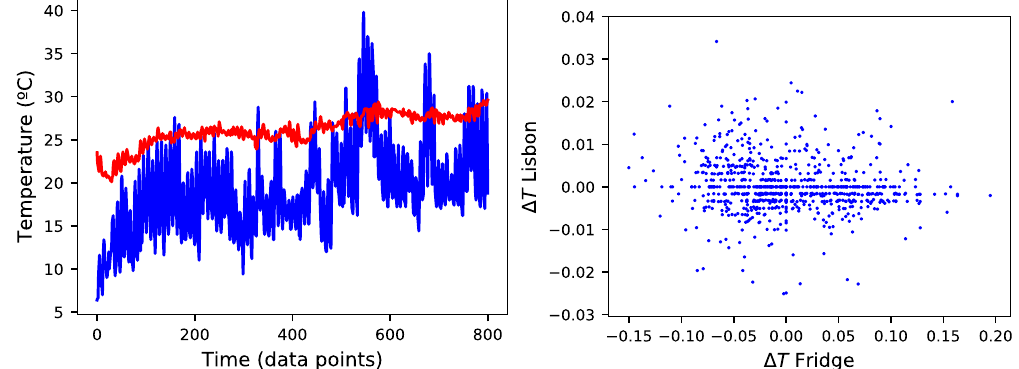
Figure 1. ( Left ) Evolution of the two considered time series, representing the indoor (red line) and outdoor (blue) temperature in Lisbon, Portugal. ( Right ) Evolution of the changes in the outdoor temperature, as a function of the indoor one—see main text for